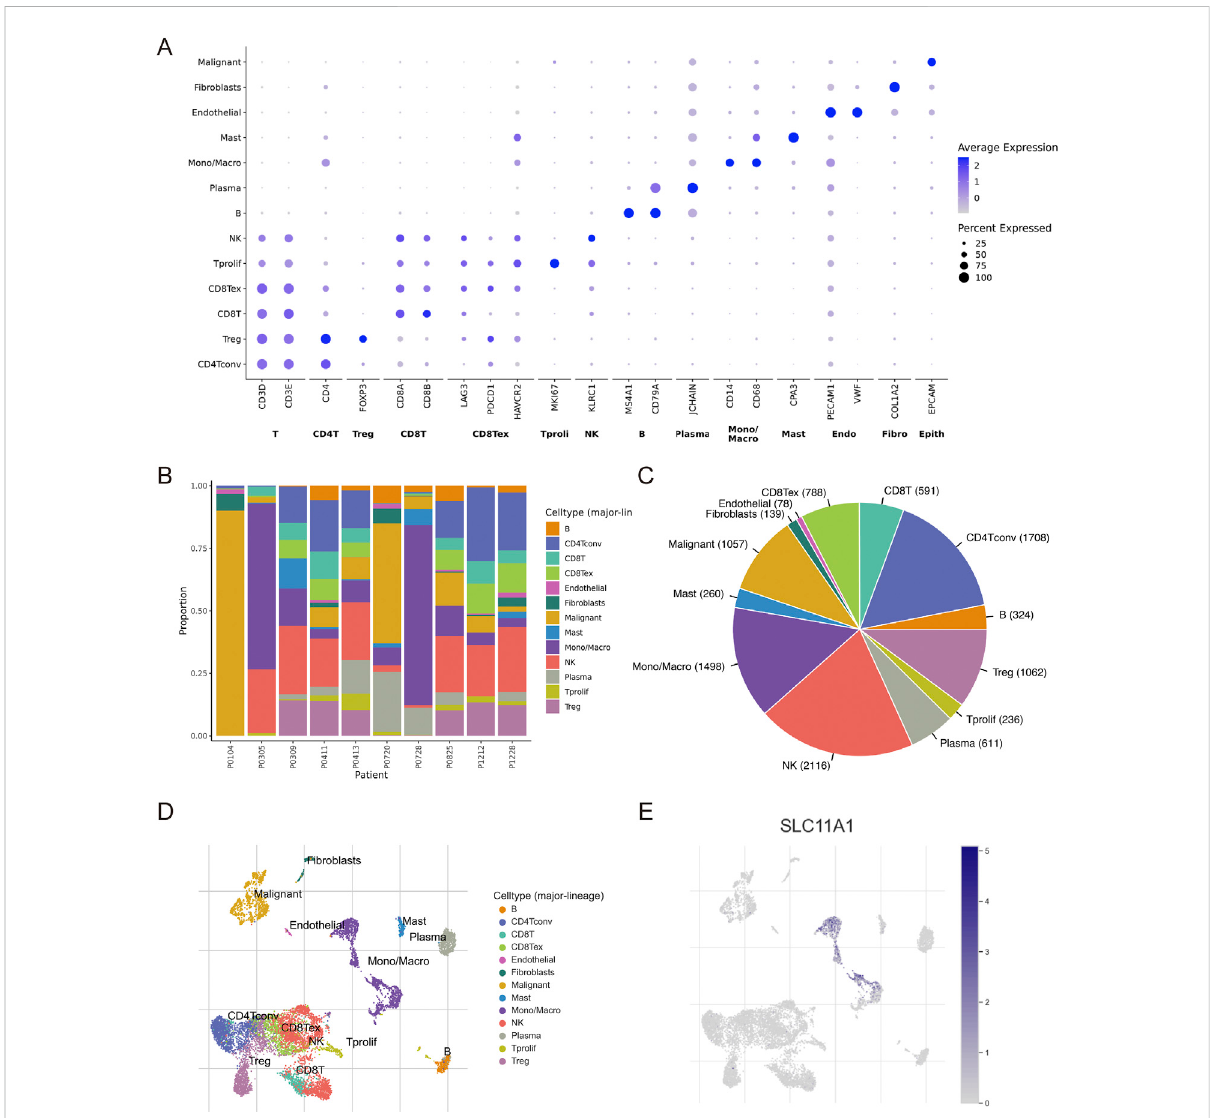
FIGURE 6 Single-cellanalysistoexplorethecelllocationofSLC11A1. (A) ThebubblechartshowedtheexpressionmarkersofcellsinTMEwithGSE146771. (B,C) Proportion of 12 types of TME-related cells. (D,E) SLC11A1 expression was mainly distributed in monocytes and